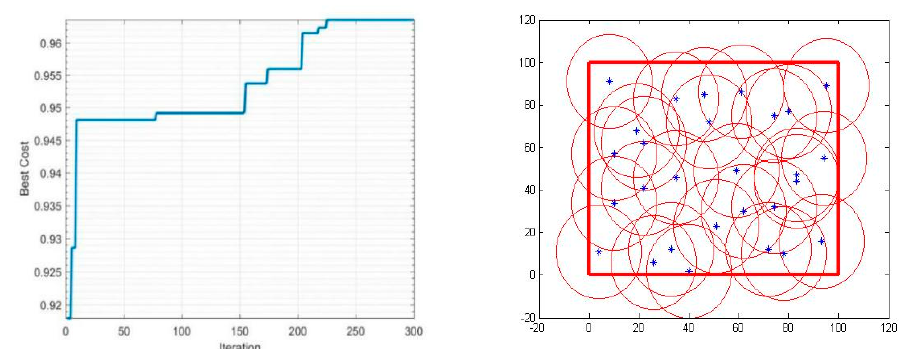
Figure 5. Coverage of 35 sensors. Figure 6. Coverage of 40 sensors. During the optimization of coverage by using the PSO algorithm, the coverage optimization went through four stages, first the deployment of 20 sensors, then 30 sensors, followed by 35 sensors, and finally 40 sensors. The simulations results are as follows: •